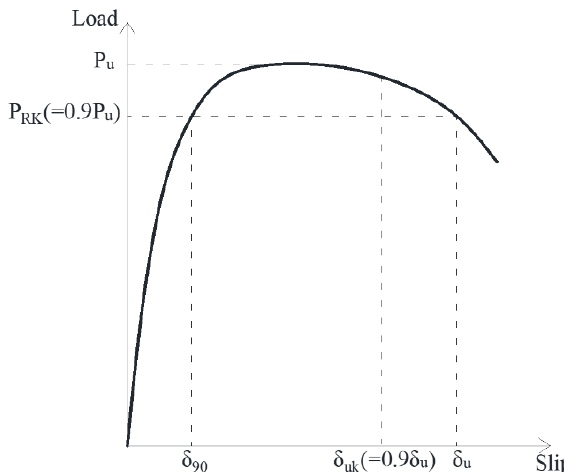
Figure 5. Evaluation method of shear resistance and ductility.